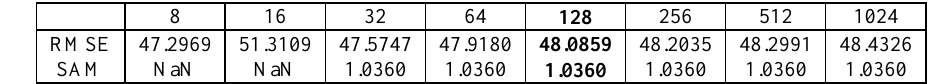
Table 5. RMSE and SAM (radian) between QuickBird multispectral and fused images using BR with different block size Note: NaN indicates the very small numerical value that can not express by